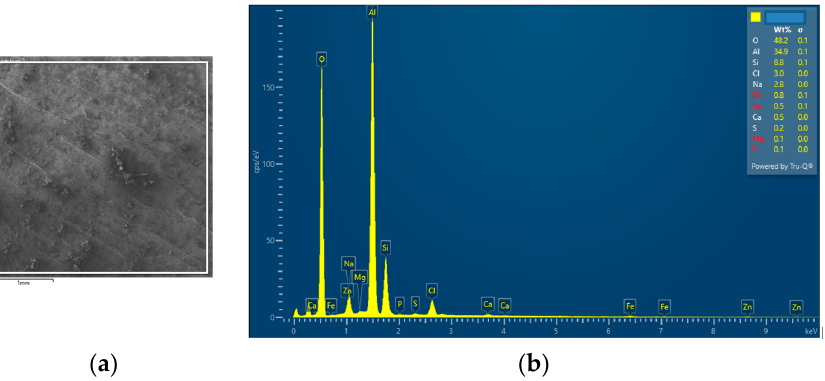
Figure 10. EDX analysis and its evaluation with respect to the local chemical composition: ( a ) chemical composition of the AlSi12 alloy used; ( b ) sample SAM 1.